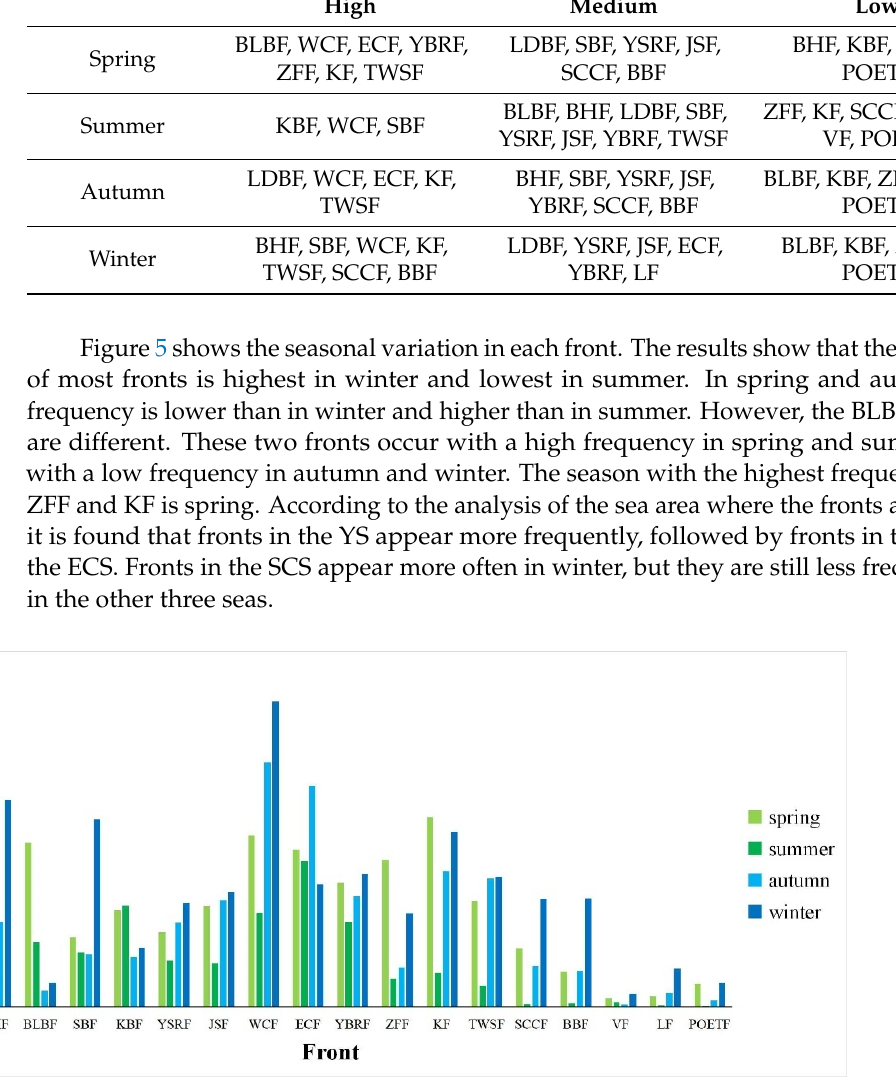
Table 2. Seasonal high-, medium-, and low-frequency fronts. High Medium Low Spring BLBF, WCF, ECF, YBRF,